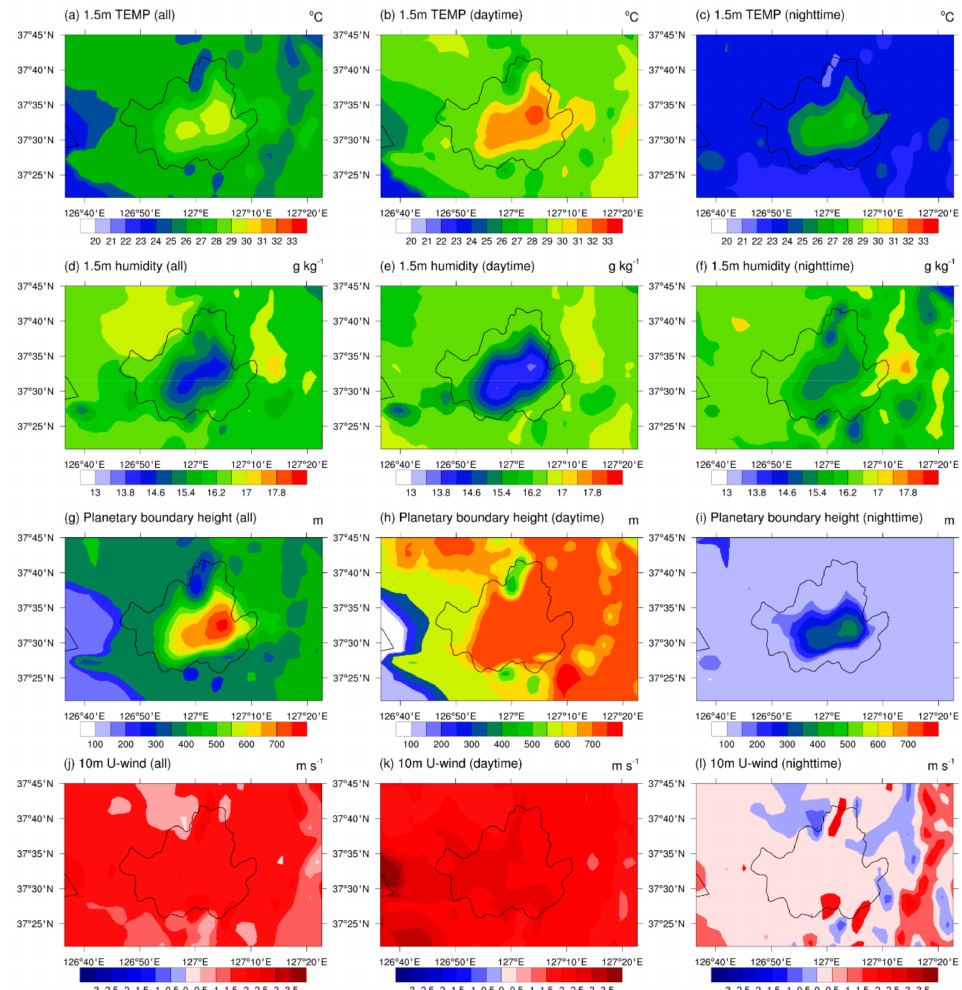
Figure 3. Distributions of daily (left), daytime (middle), and nighttime (right) means of 1.5-m temperature ( a – c , ◦ C), specific humidity ( d – f , g kg − 1 ), planetary boundary height ( g – i , m), and 10 m zonal wind ( j – l , m s − 1 ) in